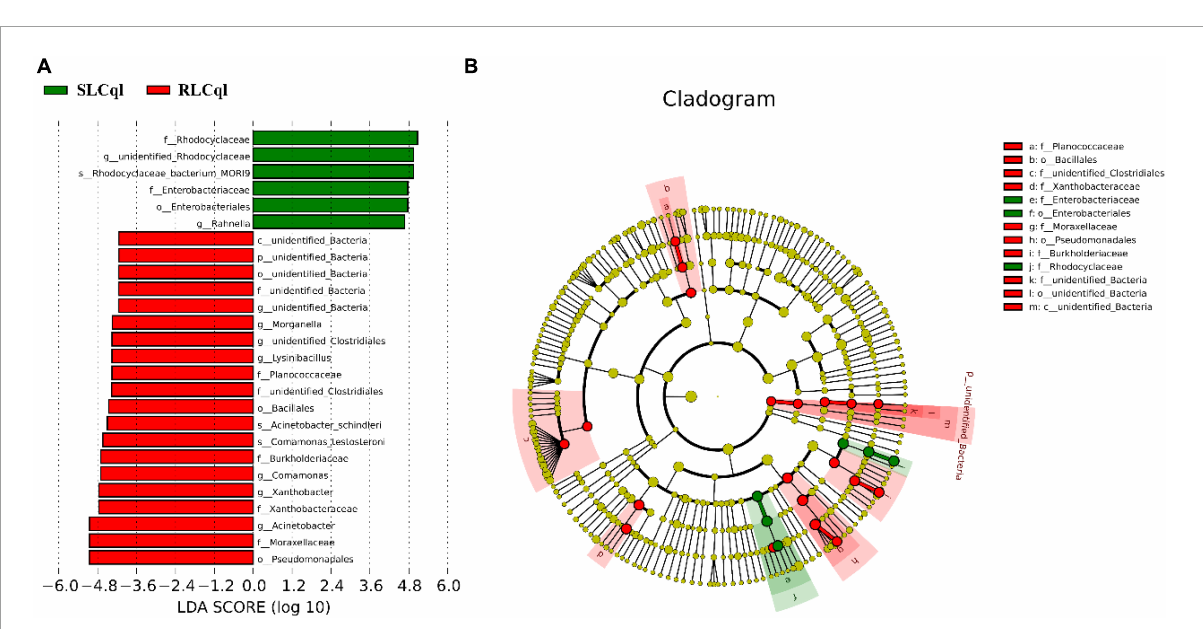
FIGURE4 Taxons identified from Line Discriminant analysis (LDA) Effect Size (LEFSe) for strains of Culex quinquefasciatus that are susceptible (SLCql) and resistant (RLCql) to Lysinibacillus sphaericus C 3 -41. (A) Taxonomic cladogram. Taxa enriched in RLCql or SLCql are colored red or green, respectively. (B) SLCq1-enriched taxa are shown with a positive LDA score (green), and taxa enriched in RLCql are shown with a negative score (red). Only taxa meeting an LDA significance threshold > 4 and p < 0.05 are